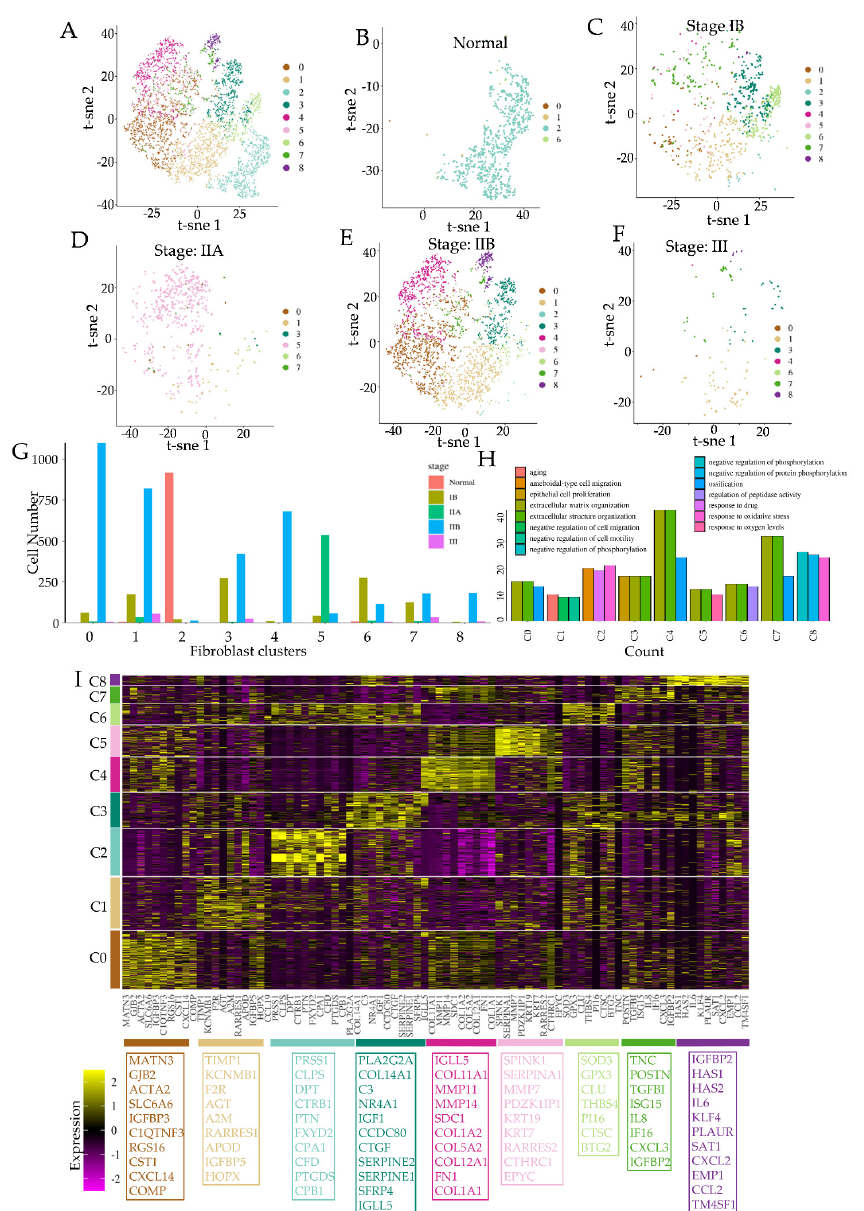
Figure 1. Metastatic progression of pancreatic ductal cell carcinoma (PDAC) is associated with dynamic emergence of fibroblast subclasses with distinct transcriptional profiles. ( A – F ) Fibroblasts exhibit dramatic changes in transcriptomic diversity across progressive stages of PDAC cancer. ( A ) t-sne representation of fibroblasts from all pooled samples of PDAC cancers as well as nor- mal pancreas [17] clustered to highlight their transcriptomic differences; t-sne representation of fibroblasts clustered for all pooled samples, and shown for ( B ) normal, ( C ) stage IB (T1N0M0) with tumor size < 2 cm, ( D ) IIA (T2 N0M0) with tumor size < 4 cm, ( E ) IIB (T1/2N1M0) with lymph metastasis < 3 nodes, and ( F ) III (T1/2/3N1/2/M1) with distal metastasis; Quantification of the proportion of fibroblast clusters at different stages of PDAC in ( G ). ( H ) Gene ontology activation scores in different fibroblast clusters; each term is obtained by differential gene expression analysis (log2fc ≥ 0.5, p -value ≤ 0.05). ( I ) Heatmap showing top 10 genes as markers for each fibroblast cluster, compared to all fibroblasts; colors to the left and the bottom correspond to the fibroblast clusters identified in t-sne representation in